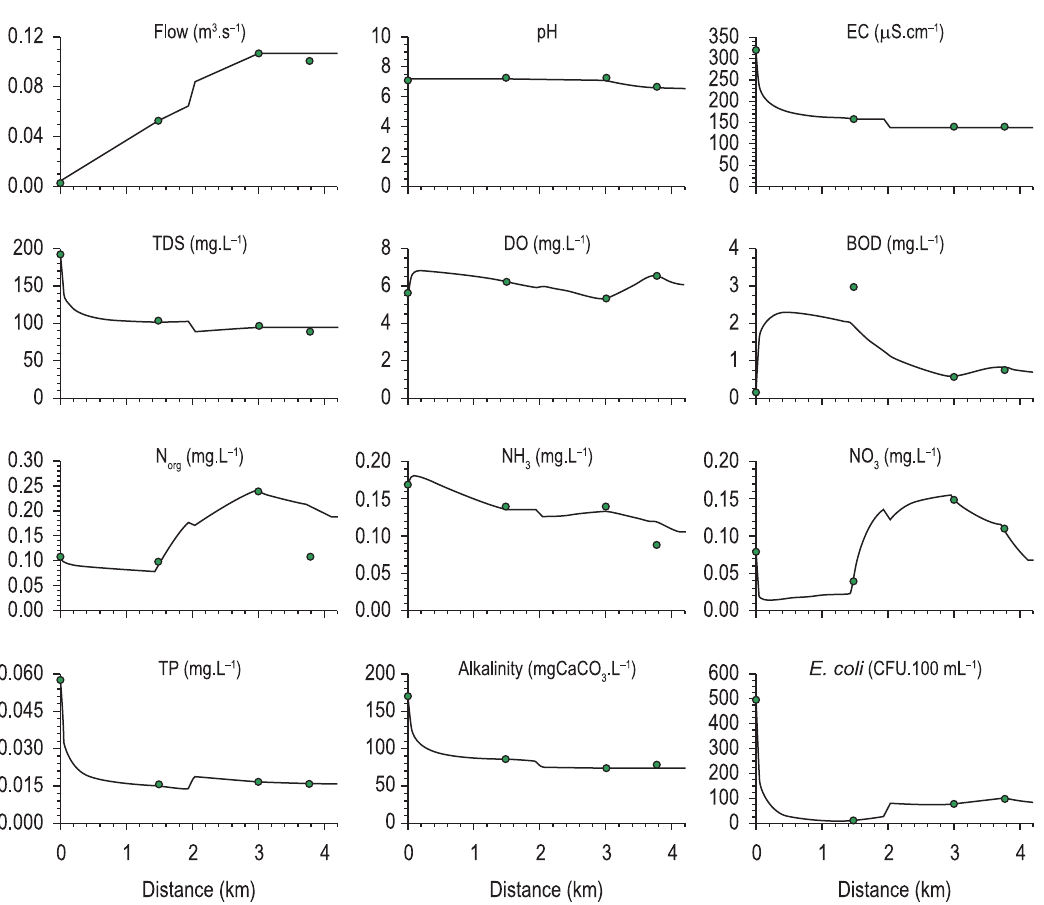
Figure 6. Model calibration results for the water quality parameters in the Fidalgo Stream using the rainy season data. Table 5. Water quality parameters measured along the Fidalgo Stream and tributary during the dry period. Monitoring